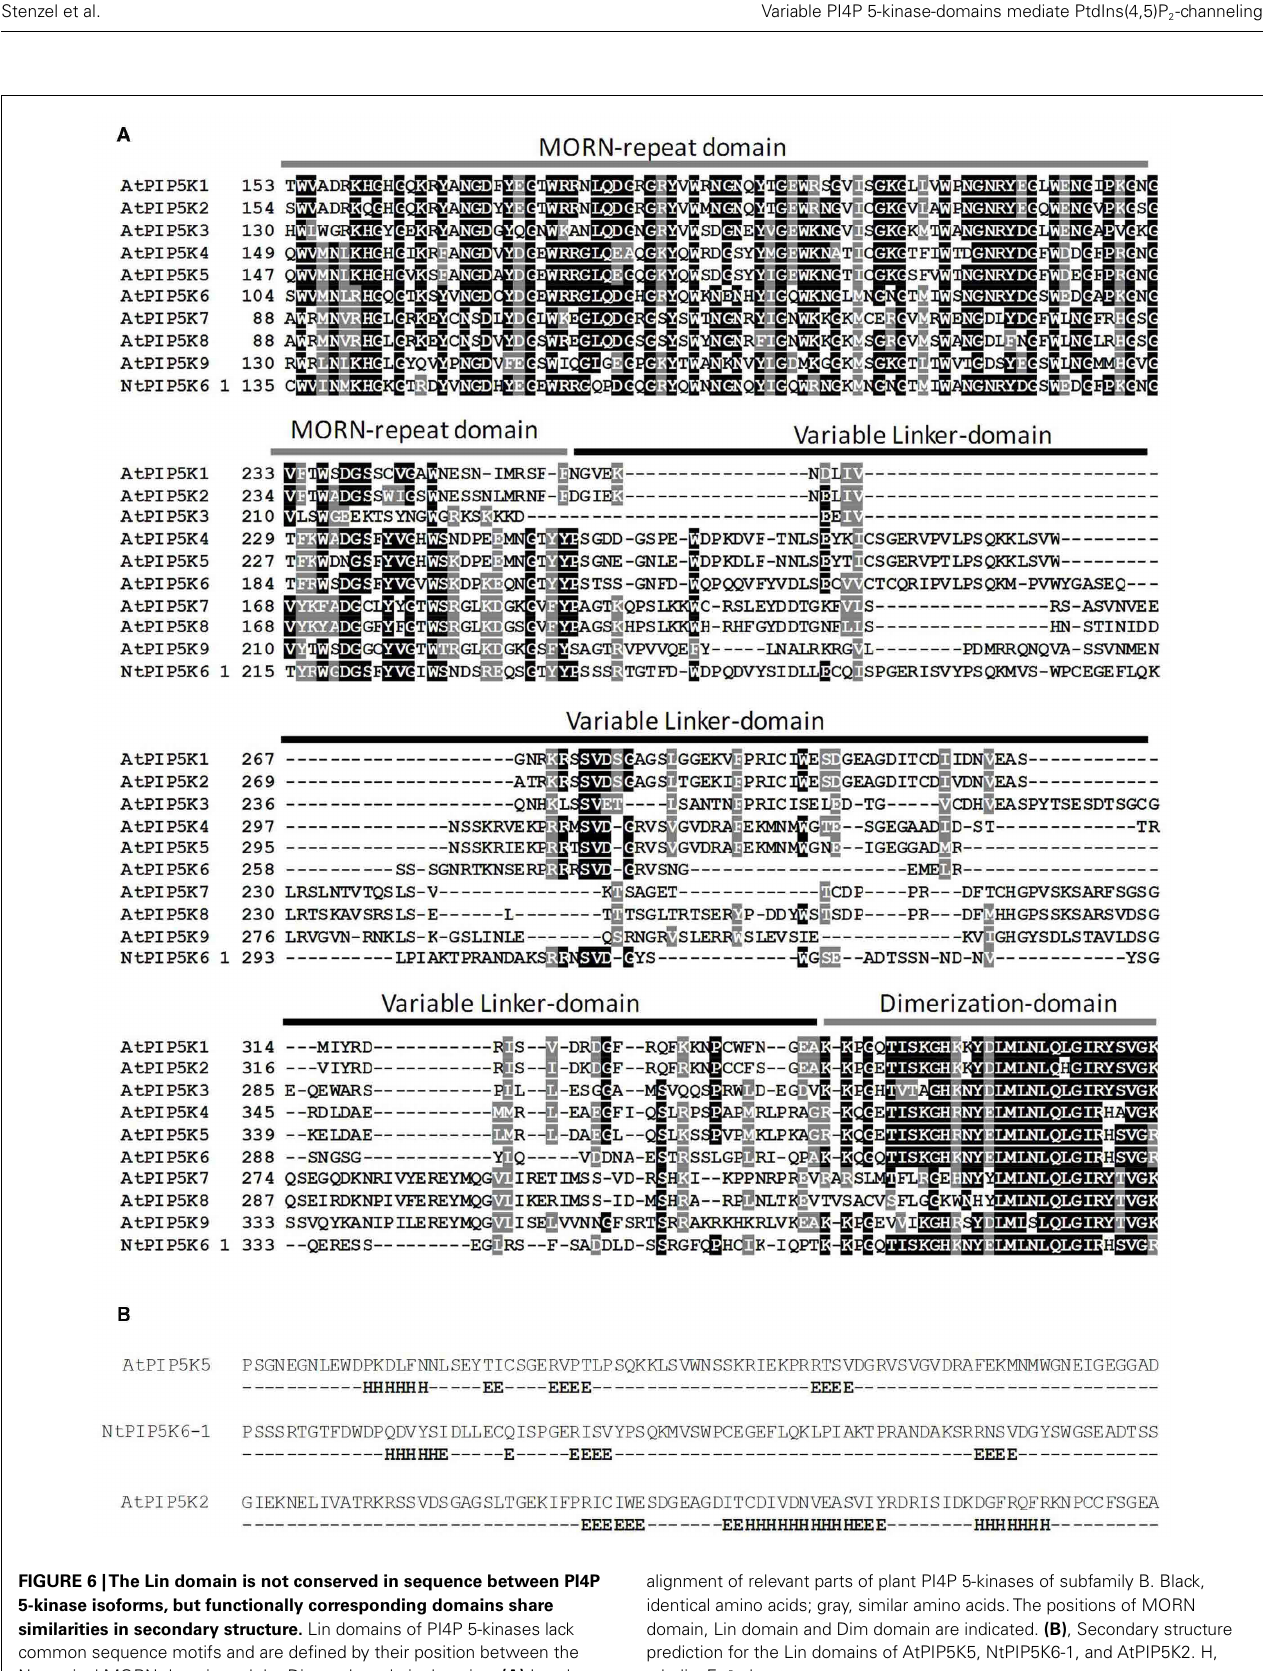
FIGURE 6 |The Lin domain is not conserved in sequence between PI4P 5-kinase isoforms, but functionally corresponding domains share similarities in secondary structure. Lin domains of PI4P 5-kinases lack common sequence motifs and are defined by their position between the N-terminal MORN domain and the Dim and catalytic domains. (A) Local